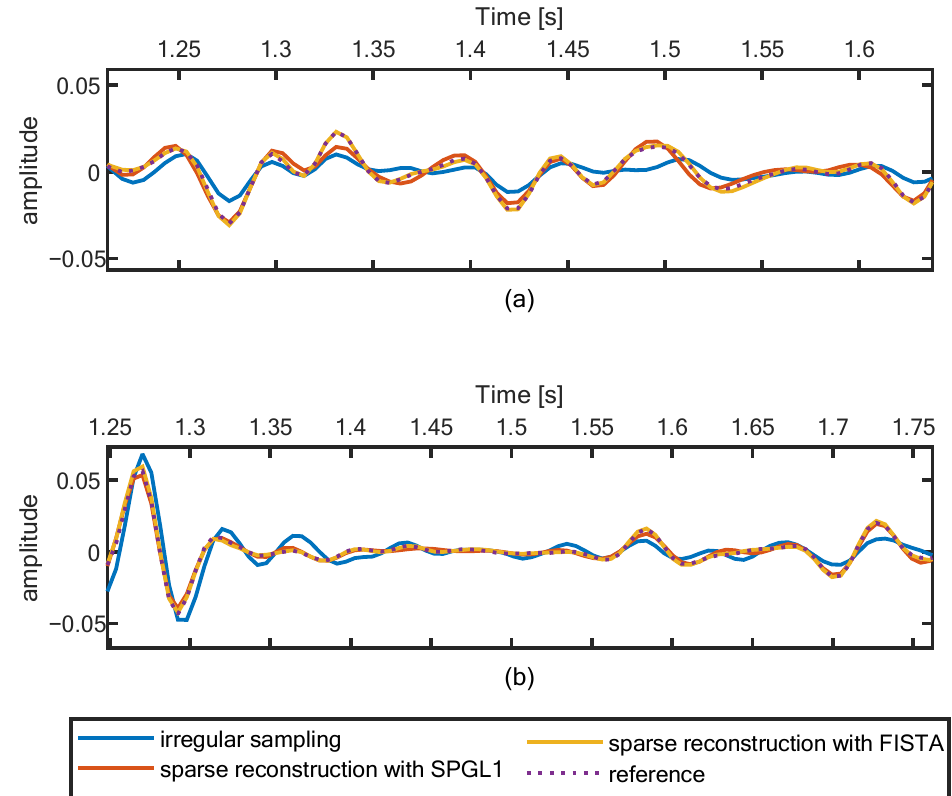
Figure 12. To compare the amplified traces of the Green’s functions of Figure 10a–d, which are blue, red, yellow, and purple, respectively. They are at ( a ) near offset x = 10 m and ( b ) far offset x = − 960